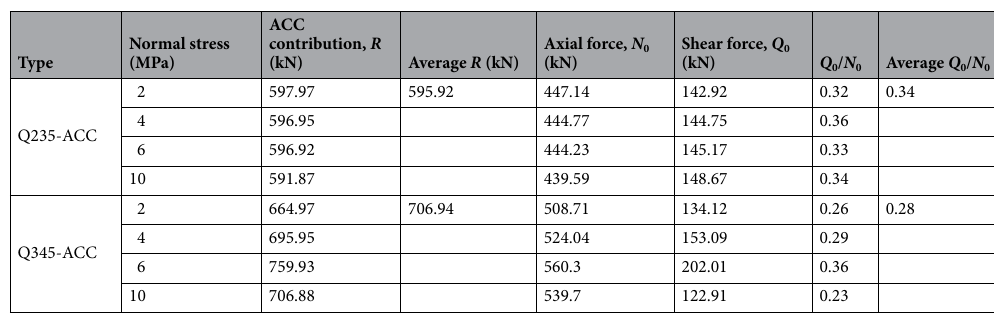
Table 4. Statistics of the ACC contribution and the axial and shear forces at failure.